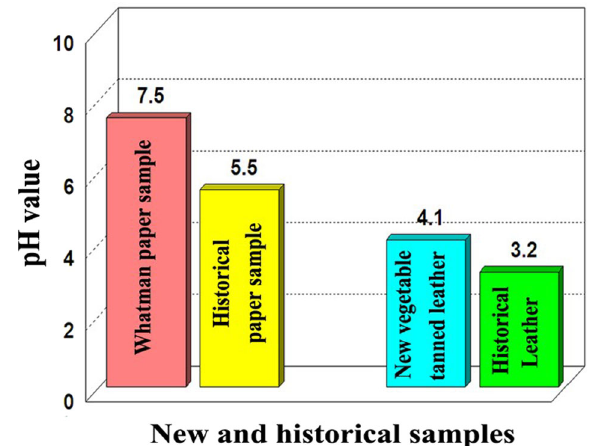
Fig. 6 Measurement of the pH values. The pH values of the papers and leather binding of a historical manuscript compared to control.